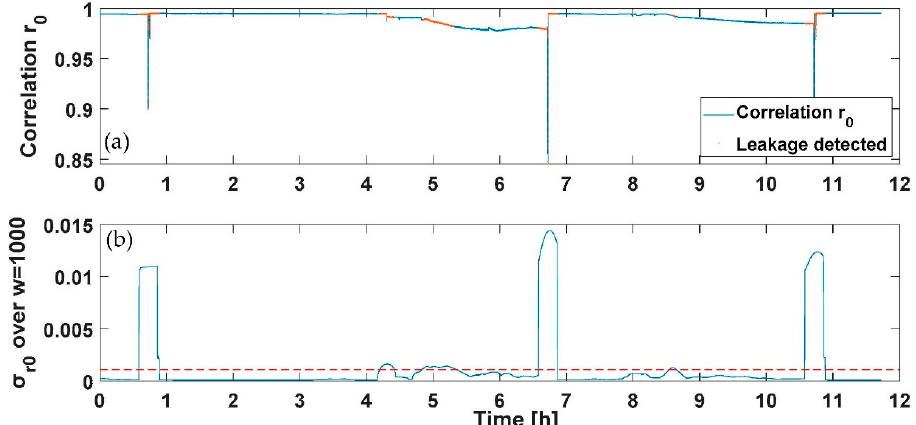
Figure 11. Test on dynamic profile with a continuous leakage for the piston water meter: ( a ) the r 0 correlation and the point detected corresponding to consumption in red, and ( b ) the moving average σ r0 and in red the threshold retrieved from Table 3 to discriminate a flow rate different from zero.